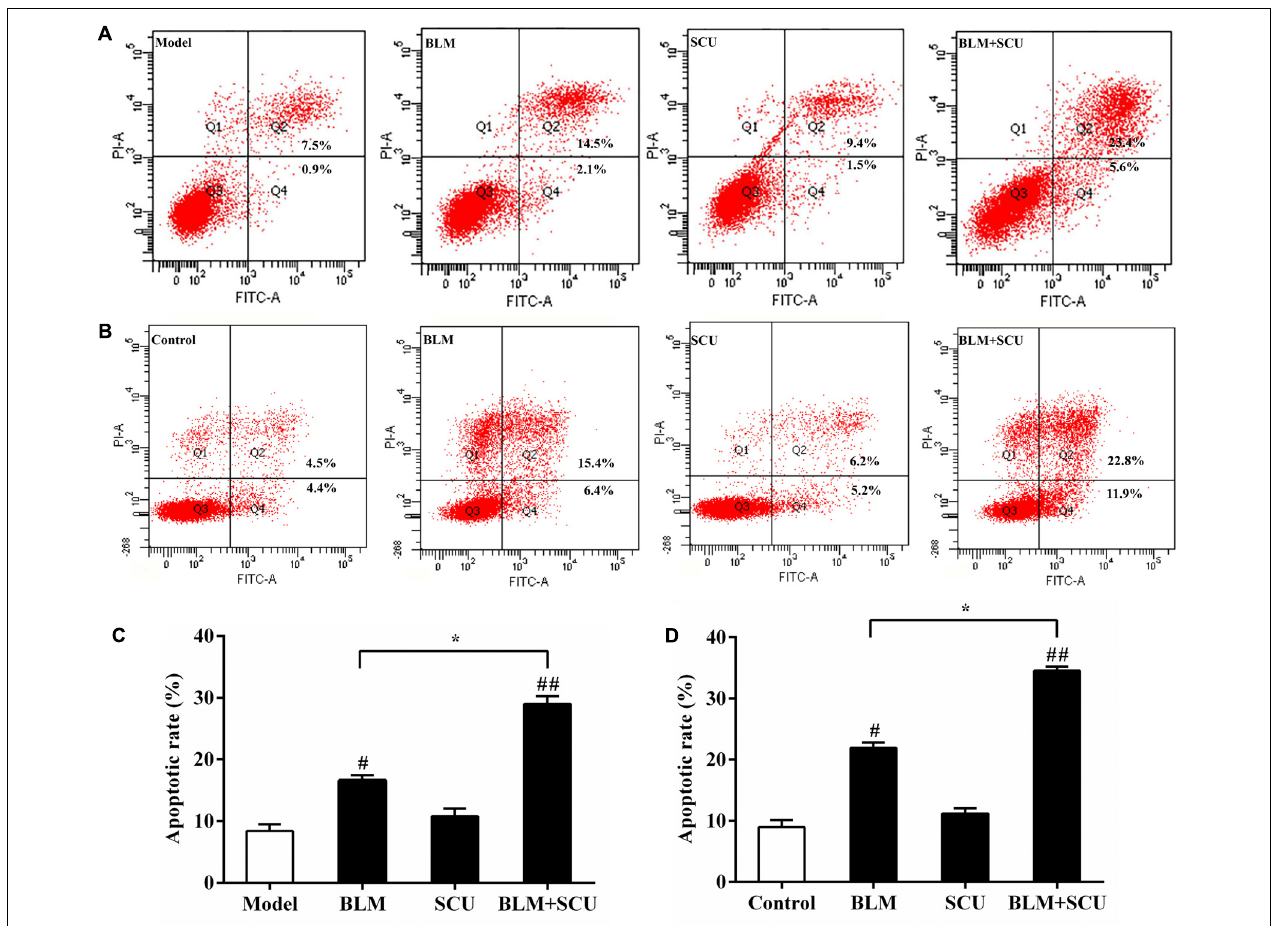
FIGURE 3 | Effects of BLM, SCU, and their combination induce apoptosis of H22 ascites cells and the H22 cells cultured in vitro . The apoptosis rate of (A) H22 ascites cell and (B) the H22 cells cultured in vitro were analyzed by Flow cytometry. (C) H22 ascites cell and (D) in vitro H22 cell apoptotic rates were calculated. The apoptotic cells in the Q2 region are late apoptotic cells stained with FITC+/PI+ and the apoptotic cells in the Q4 region are early apoptotic cells stained with FITC+/PI–. The total apoptotic rate of cells was the sum of the apoptotic rates of Q2 and Q4. Data are expressed as the mean ± SD. ( n = 4). # p < 0.05 compared with model group; ## p < 0.01 compared with model group; ∗ p < 0.05 compared with BLM group.